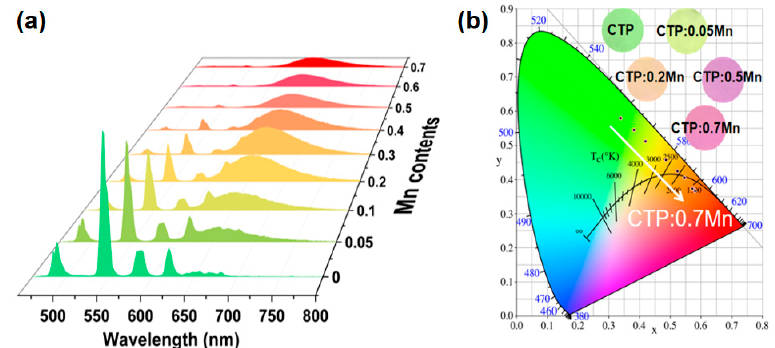
Figure 4. ( a ) PL spectra of CTP: x Mn 2+ ( x = 0.05, 0.1, 0.2, 0.3, 0.4, 0.5, 0.6 and 0.7), and ( b ) CIE coordinate diagram and representative photographs.